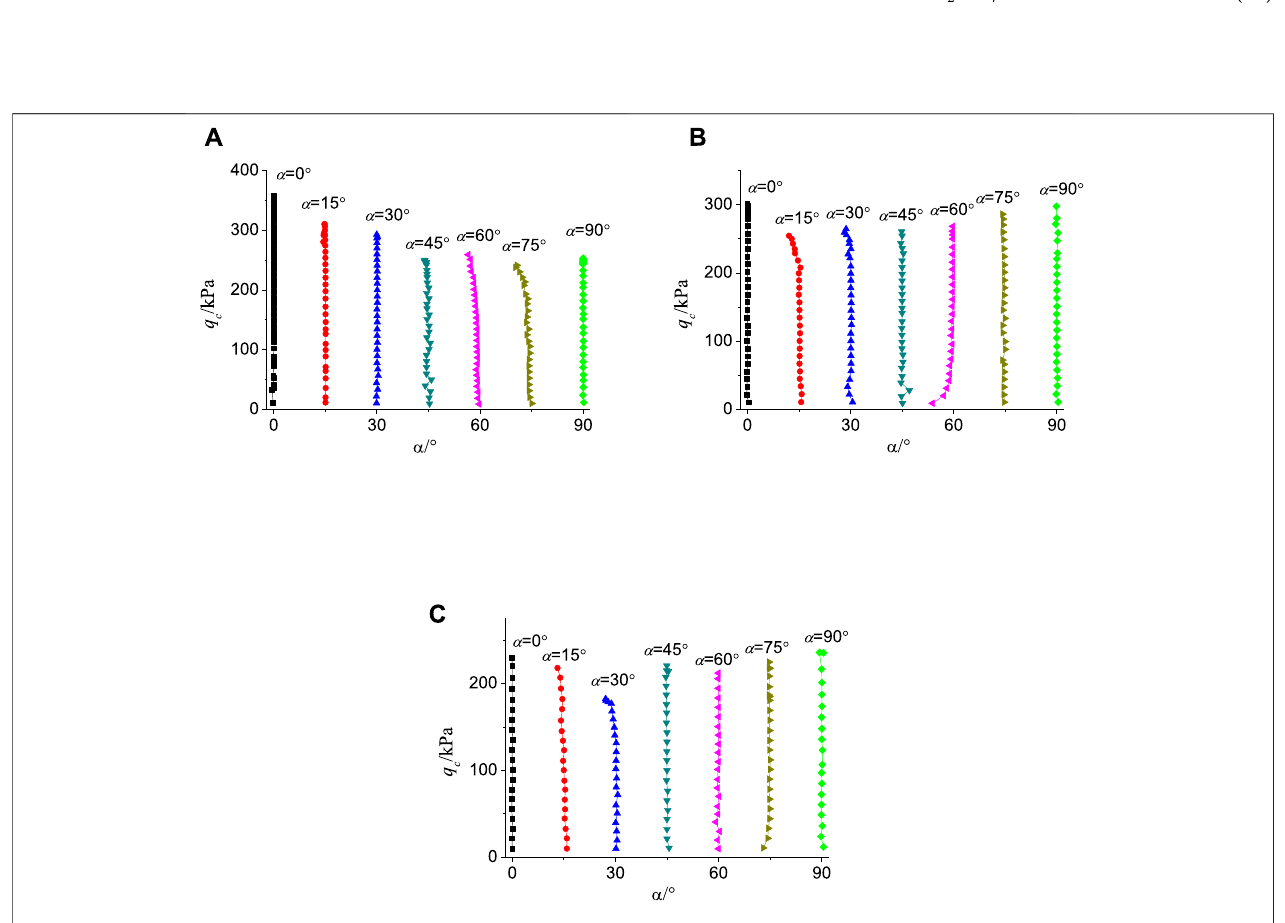
FIGURE 4 | Actual loading stress path; (A) b = 0 q c ~ α ; (B) b = 0.5 q c ~ α ; (C) b = 1 q c ~ α